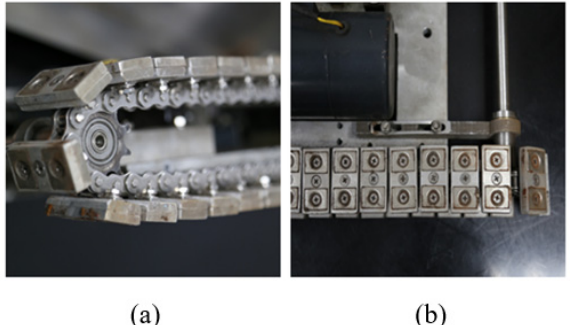
Figure 13. The details of tracks and adhesion mechanisms; ( a ) side view; ( b ) top view.